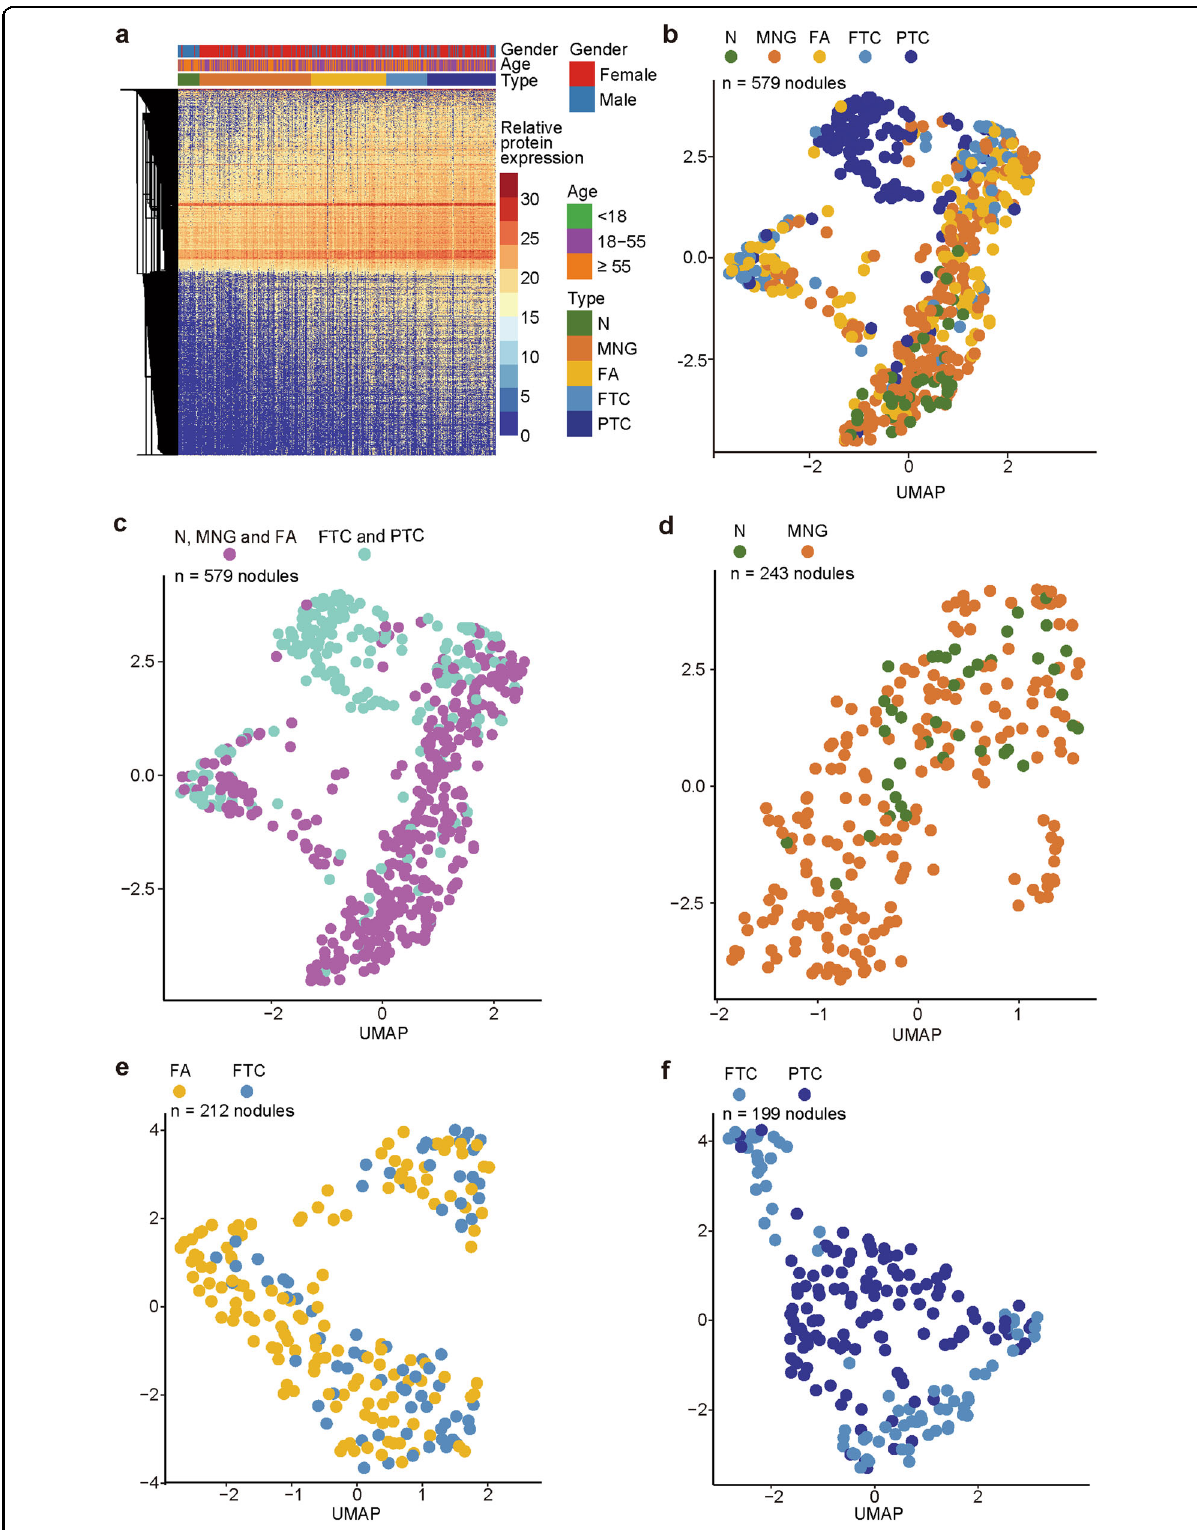
Fig. 2 Global thyroid proteome pro fi le. a Heatmap showing protein expression pro fi les of 579 thyroid tissue specimens from 578 patients. 5312 proteins (rows) are clustered without supervision. Samples (columns) are ordered based on the tissue types. The color indicates the log 2 -scaled intensity of each protein in each sample. b – f UMAP plots showing global snapshots comparing the indicated types of thyroid tissues using 5312 proteins for all subtypes ( b ); benign vs malignant ( c ); only benign ( d ); FA vs FTC ( e ); and only malignant ( f ) tissue